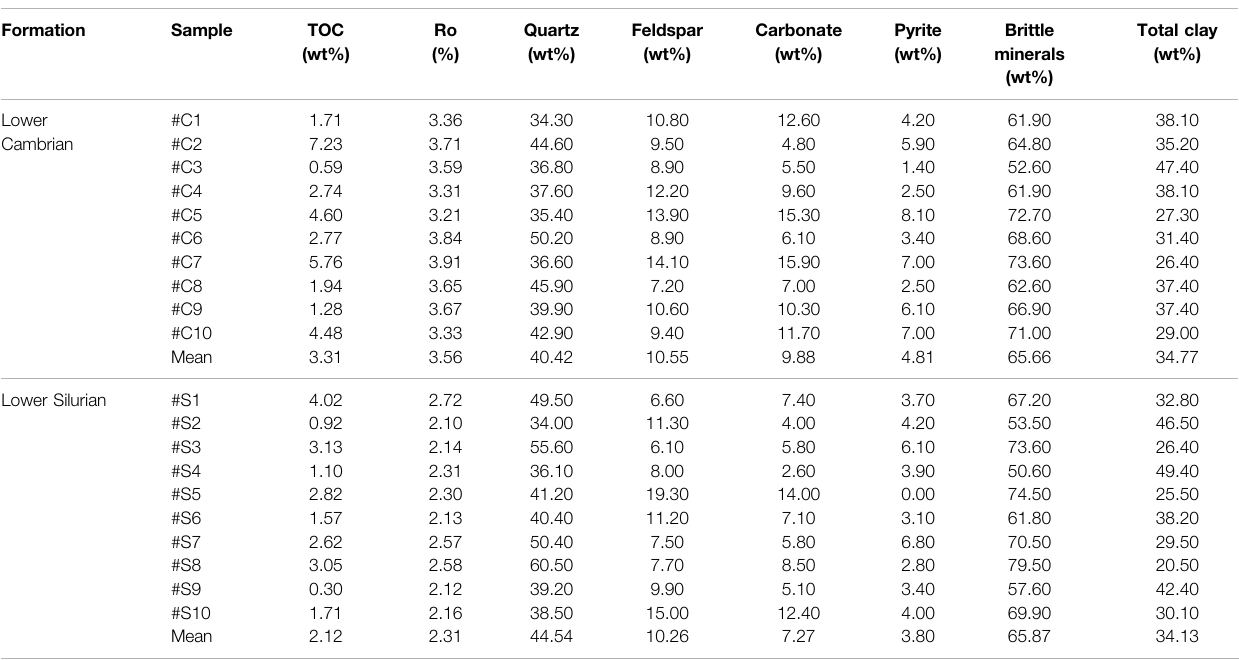
TABLE 1 | Basic geochemical and petrologic parameters of the investigated samples. Formation Sample